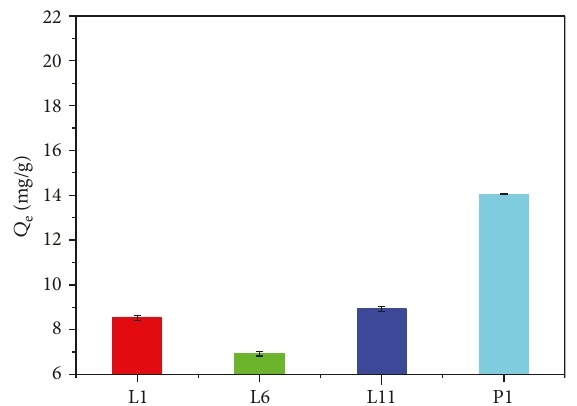
Figure 6: Comparison of the BSA adsorption levels of L1, L6, L11, and